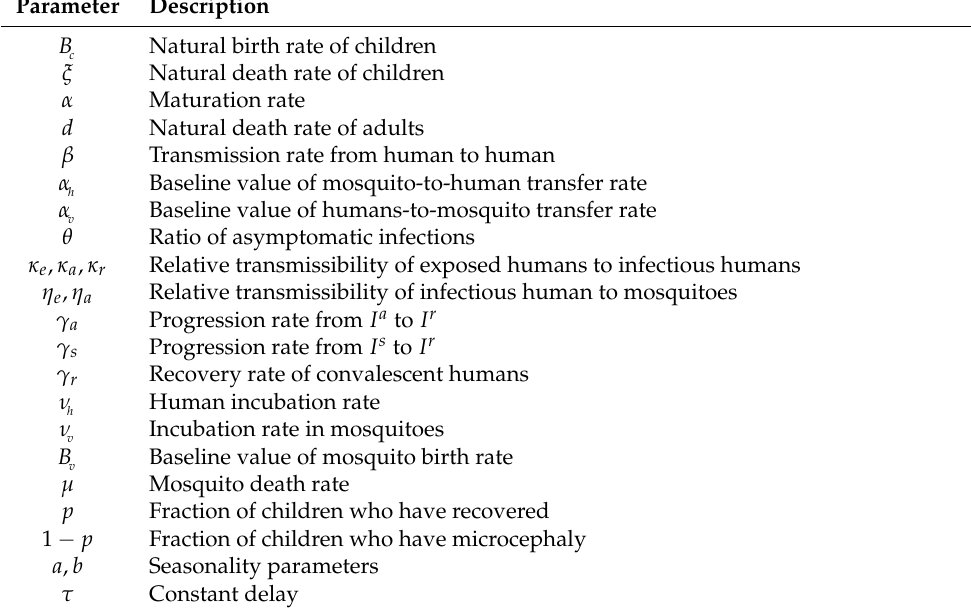
Table 1. Description of the model (1)